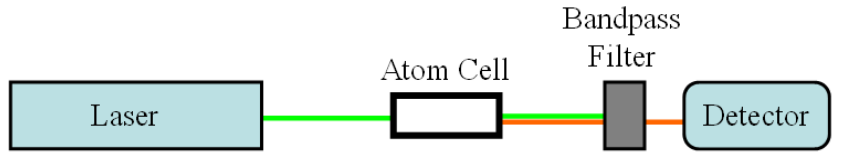
Figure 1. A general schematic of the experimental setup for LEAFS